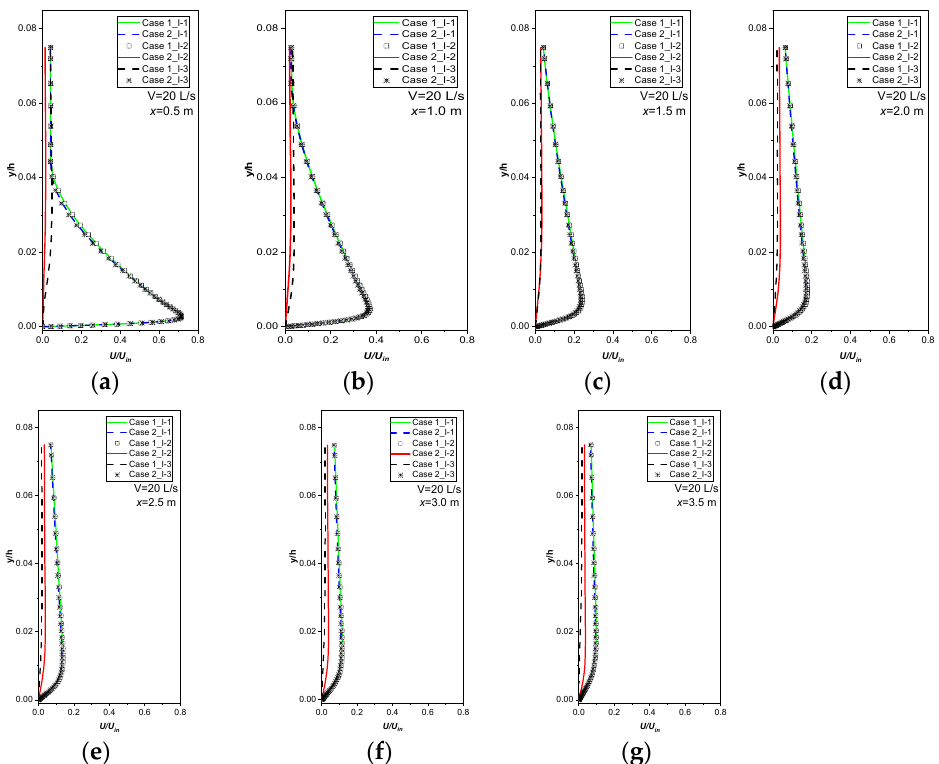
Figure 4. ( a – g ) Show the velocity changes along the centerline of the floor for all evaluated cases with V = 20 L/s at x distances 0.5–3.5 m.